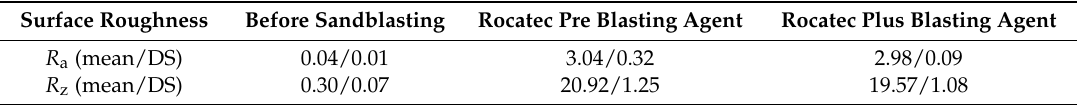
Table 3. Surface roughness R a and R z before and after the sandblasting of PMMA specimens ( n = 10). The results for Rocatec Pre and Rocatec Plus blasting agent did not exhibit statistically significant differences. (U-Test, p = 0.05).